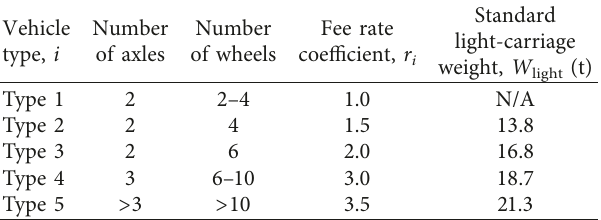
Table 3: Fee rate coefficients and standard light-carriage weight W light for various vehicle types ( i ) used to determine tolls under the initial toll-by-weight